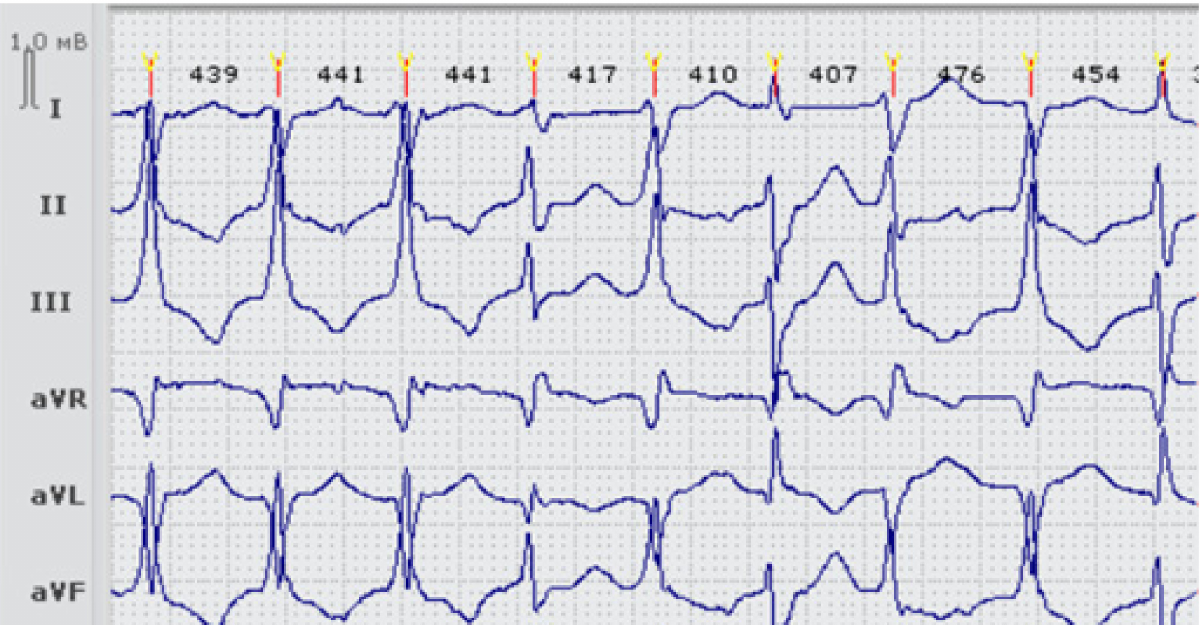
Figure 1. Fragment ECG of the proband LQTS33 (carrier of two heterozygous variants p.Arg218Gln in the KCNJ2 gene and p.Thr983Ile in the KCNH2 gene) at the first admission, before treatment. Frequent premature ventricular beats (>11,000 per